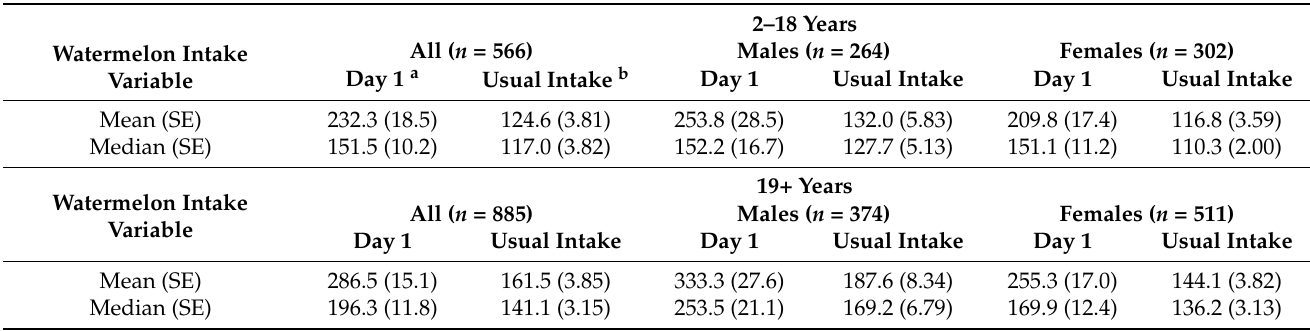
Table 3. Intake of watermelon (grams/day) by child (2–18 years) and adult (19+ years) consumers only, NHANES 2003–2018.